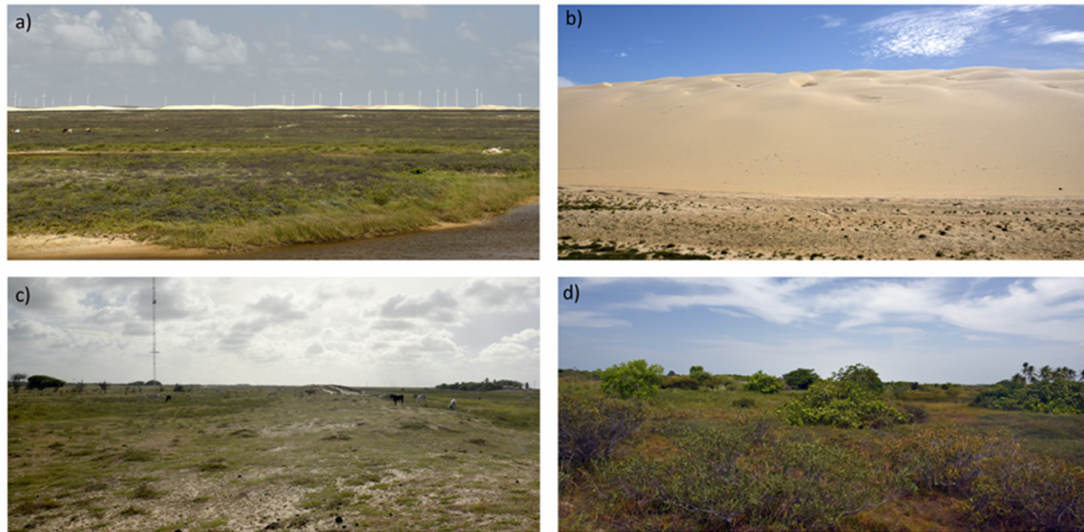
Figure 2. Typical landscapes for the study site. ( a ) Region leeward of the first array of wind turbines. ( b ) A well-developed dune field. ( c ) Grass-covered terrain. ( d ) Vegetated